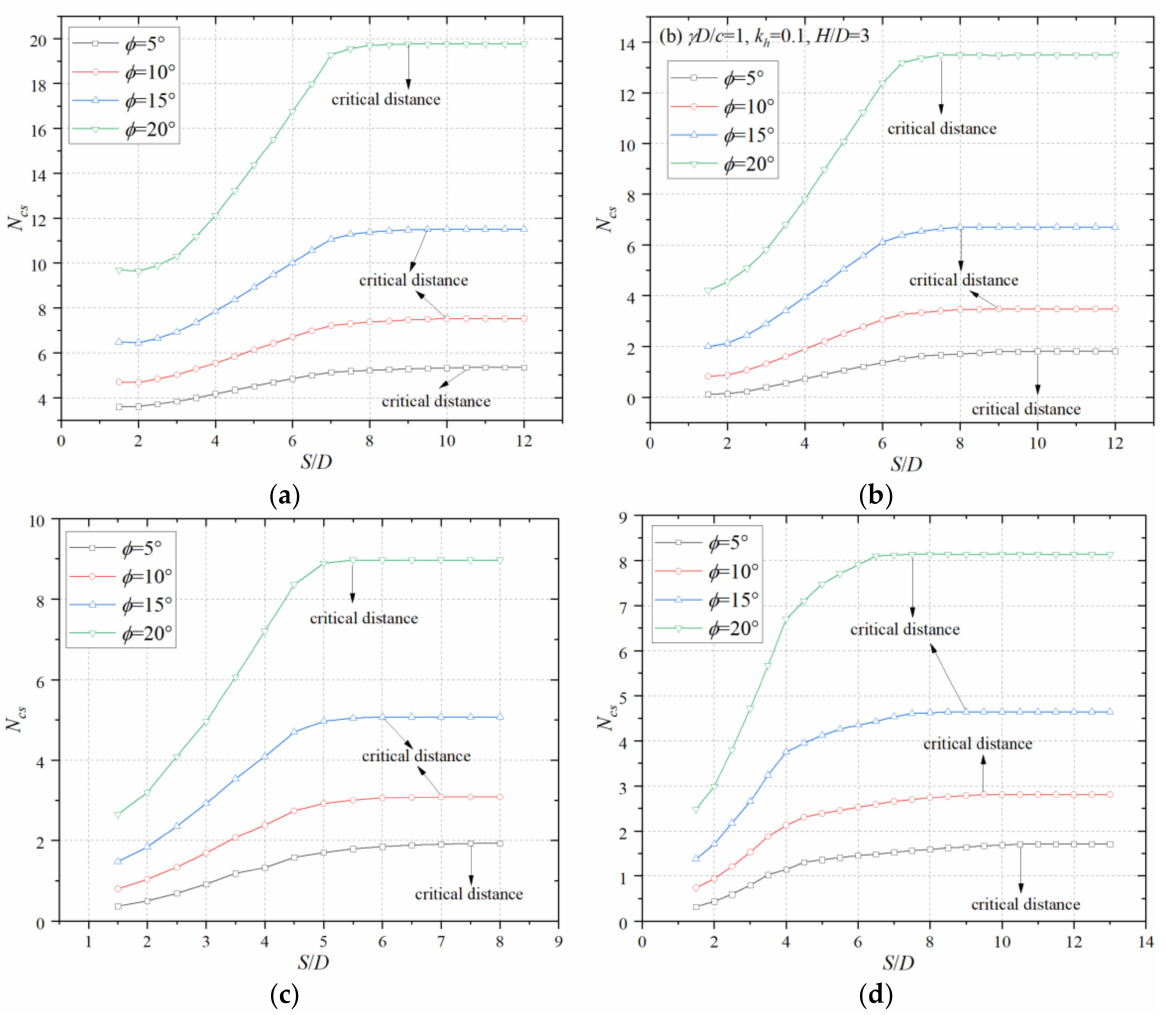
Figure 6. N cs - S / D curves with different ϕ for ( a ) γ D / c = 0, k h = 0.1, H / D = 3; ( b ) γ D / c = 1, k h = 0.1, H / D = 3; ( c ) γ D / c = 1, k h = 0.1, H / D = 2; and ( d ) γ D / c = 1, k h = 0.2, H / D =